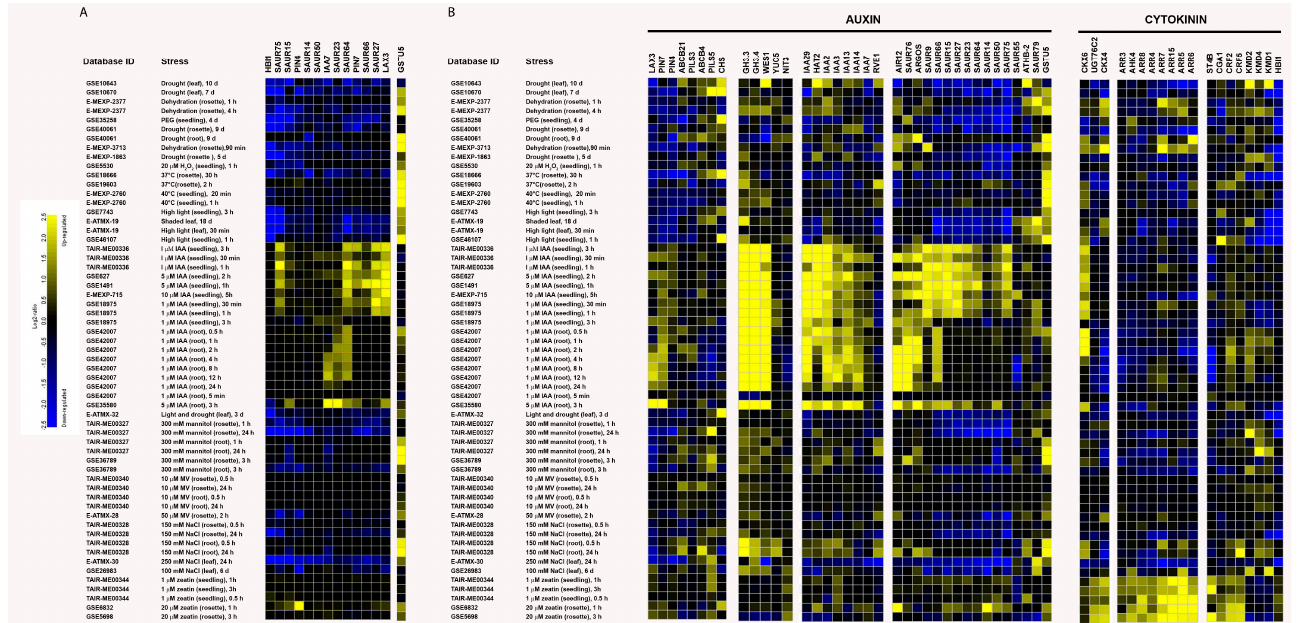
Figure 1. Auxin- and cytokinin-related genes differentially expressed by both hormones and various environmental cues. From 335 auxin- and 128 cytokinin-related genes selected from the literature and The Arabidopsis Information Resource (TAIR, Available online: www.arabidopsis.org), probes for 246 (auxin) and 128 (cytokinin) genes were found using the Genevestigator database and Affymetrix Arabidopsis ATH1 Genome Array (Available online: http://www.genevestigator.com/gv/index.jsp). We analyzed their expression upon 59 perturbations from 328 microarrays. Using perturbation tool analysis and applying fold change cut-offs of >1.5 and significance p -values of <0.05, we ended up with a total of 36 auxin-related genes and 19 cytokinin-related genes that responded to both hormones and to single or multiple stressors at the same time. The figure shows the selected experiments, which can be retrieved using the unique database ID for each. The genes’ expression responses are calculated as log 2 -ratios between the signal intensities from different perturbations as compared with control or mock-treated samples. ( A ) The panel shows a hierarchical clustering heat map from genes downregulated or upregulated simultaneously by all selected stresses. The hierarchical clustering maps for the total number of selected genes. ( B ) The panel shows the expression profile of auxin-related genes divided into 5 groups according to their roles (transport, metabolism, biosynthesis, signaling, and response genes) and 3 groups for cytokinin-related genes (metabolism, perception and signaling, and response-related genes). Gene expression patterns are represented in a log2 ratio ranging from − 2.5 (blue color, down-regulated) to +2.5 (yellow color, up-regulated). Abbreviations: d = days; min = minutes; h = hours; PEG = polyethylene glycol; MV = methyl viologen.